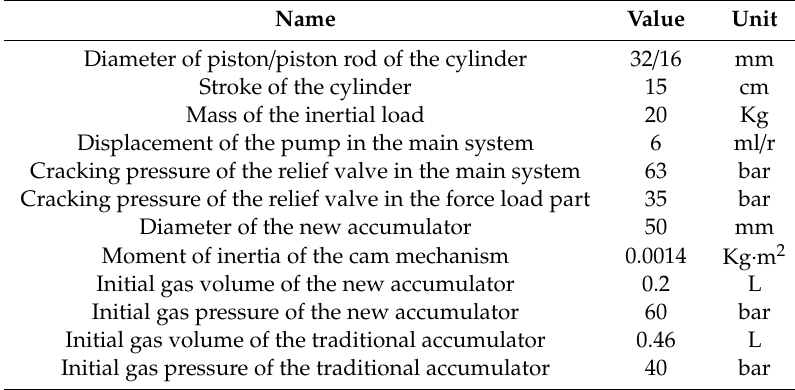
Figure 7. The experiment platform. Table 1. Main parameters of the simulation and experiment system.